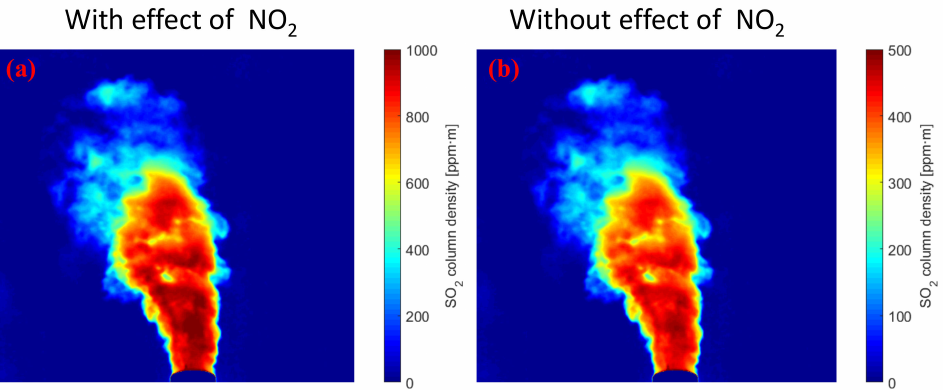
Figure 5. SO 2 CD of industrial emissions obtained by a UV camera in the absence of aerosol scattering within the plume. ( a ) ignoring the effect of NO 2 absorption; ( b ) considering the NO 2